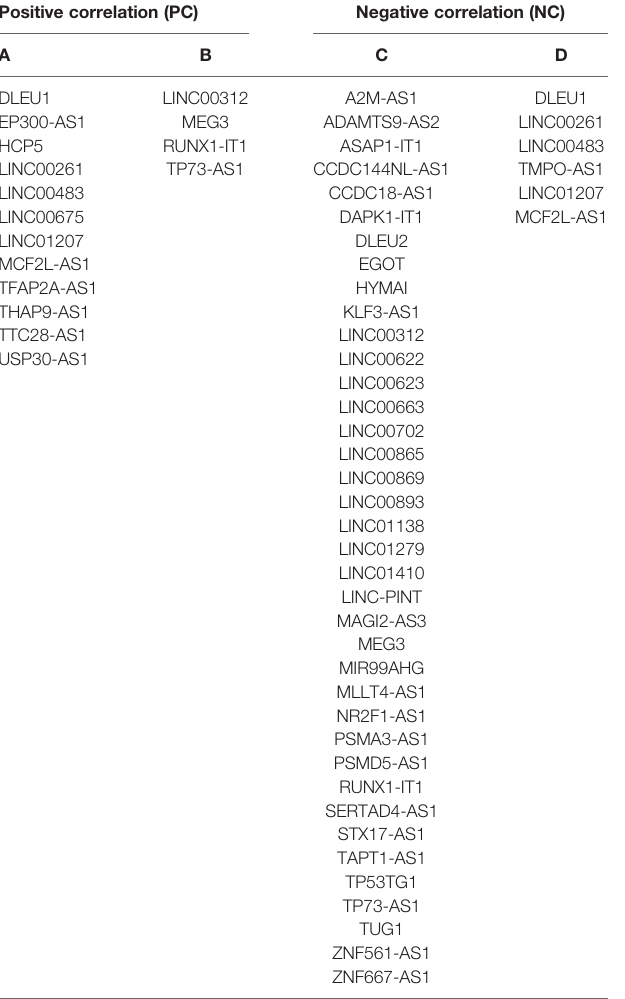
LncRNAs showing PC with downregulated BGs are shown in column A. LncRNAs showing PC with upregulated BGs are shown in column B. LncRNAs showing NC with